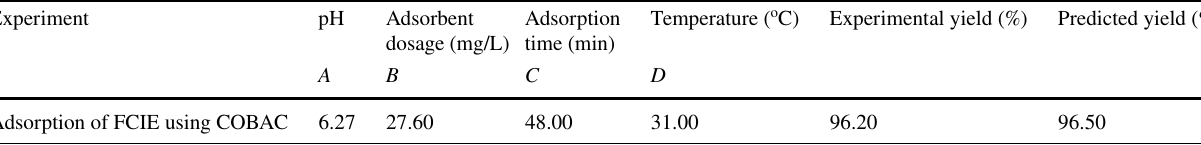
Table 7 Results of the model validation for the adsorption of FCIE using COBAC